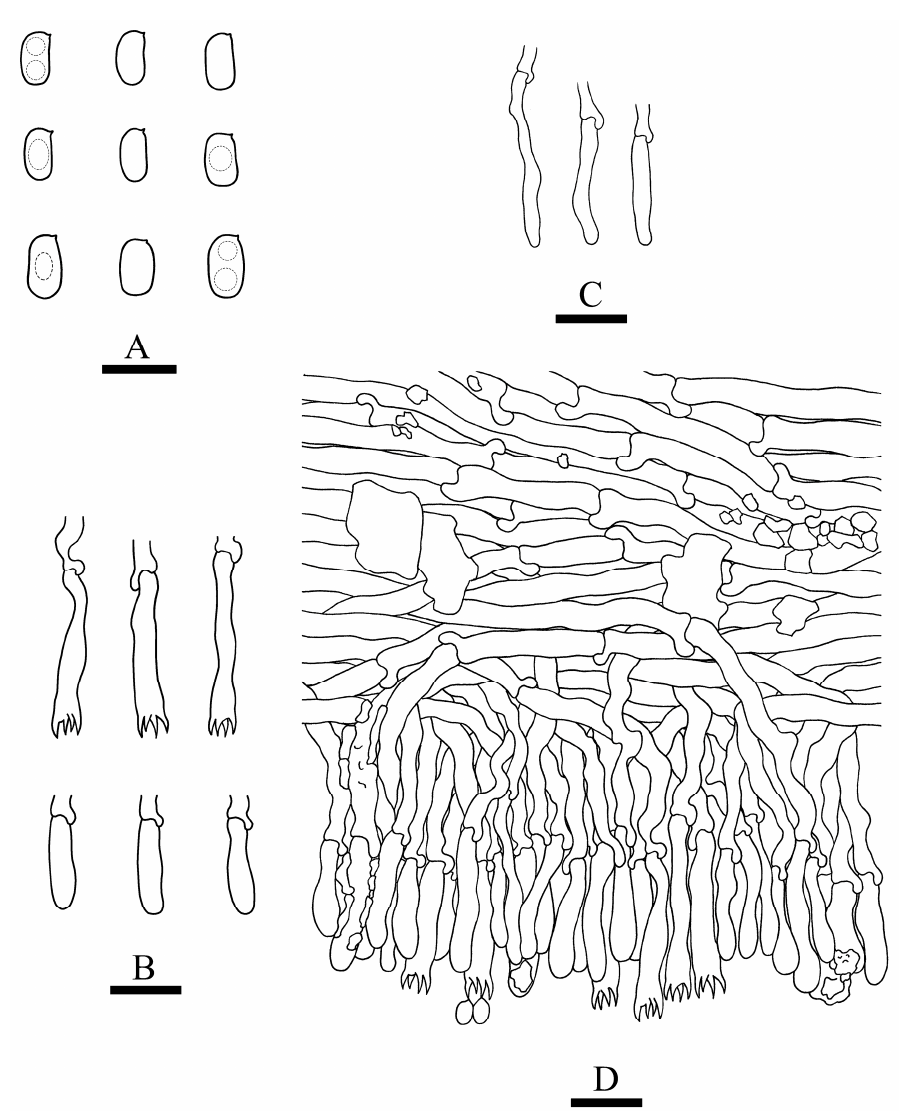
Figure 6. Microscopic structures of Hydnophlebia fissurata (drawn from CLZhao 2900, holotype). ( A ) Basidiospores. ( B ) Basidia and basidioles. ( C ) Cystidioles. ( D ) A section of hymenium. Bars: ( A ) = 5 µm, ( B – D ) = 10 µm.